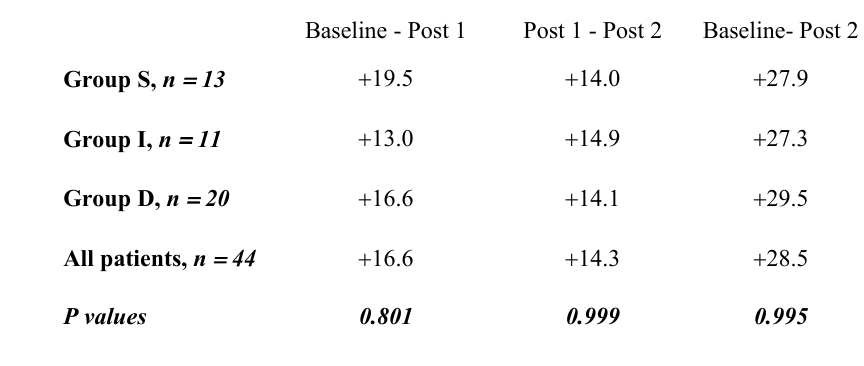
Table 2.: Percentages of mean changes in the levels of neopterin in 3 groups of patients receiving different anaes- thetics (S = Sevoflurane, I = Isoflurane, D = Desflurane).